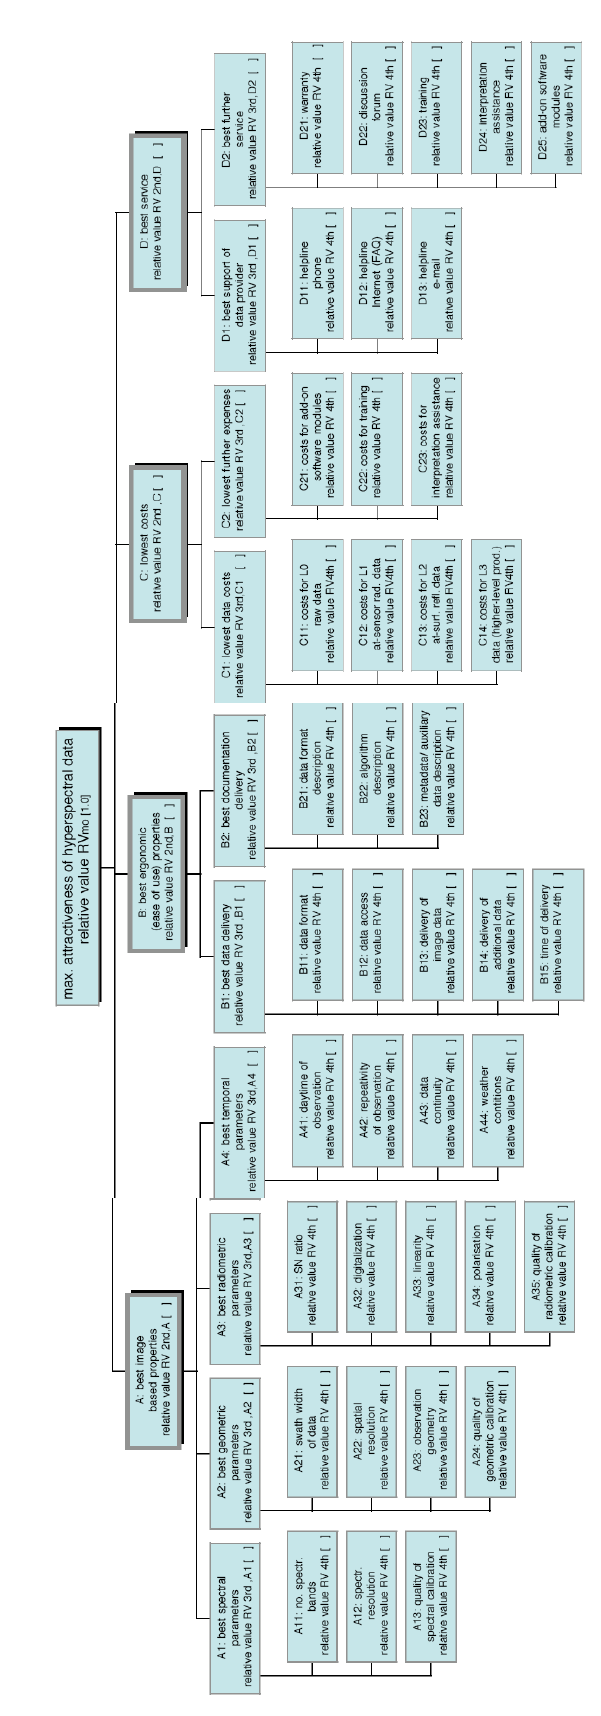
Figure 2. Objective model for satellite and airborne HSI